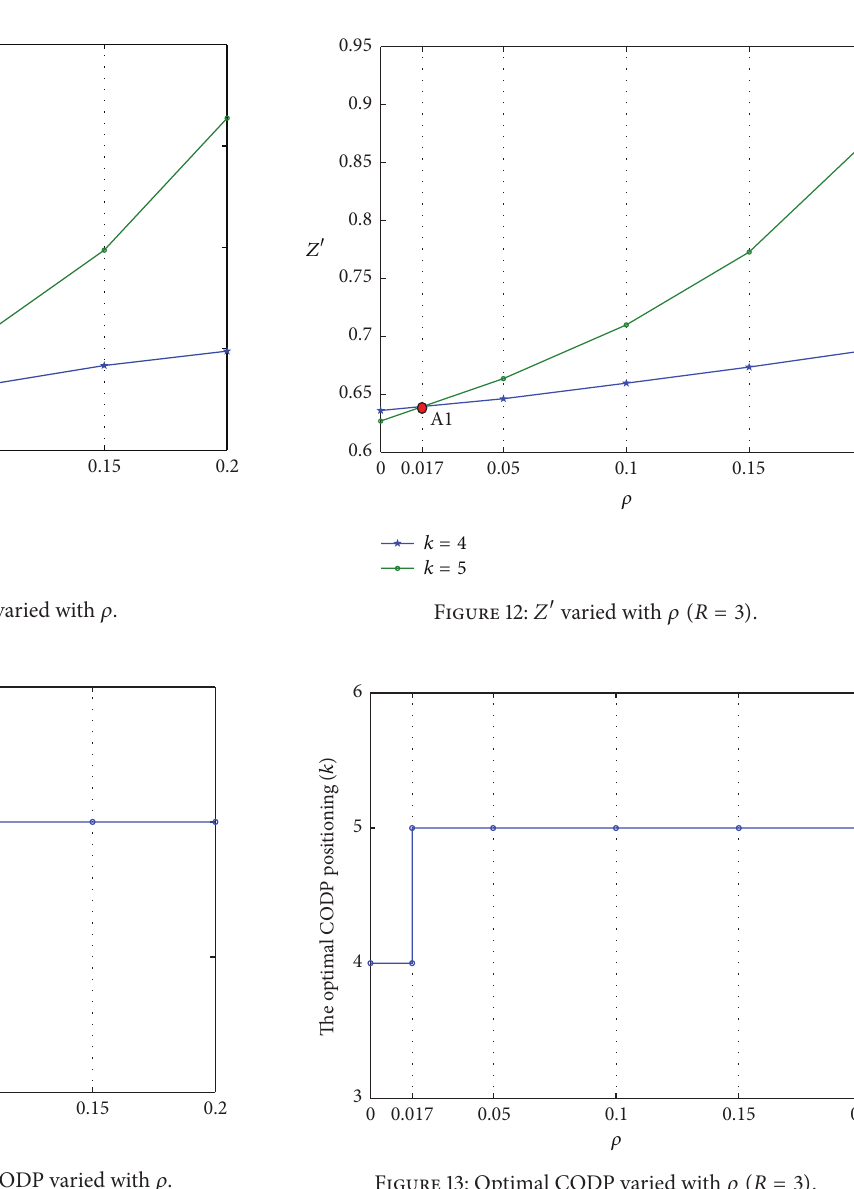
Figure 13: Optimal CODP varied with 𝜌 (𝑅 = 3)